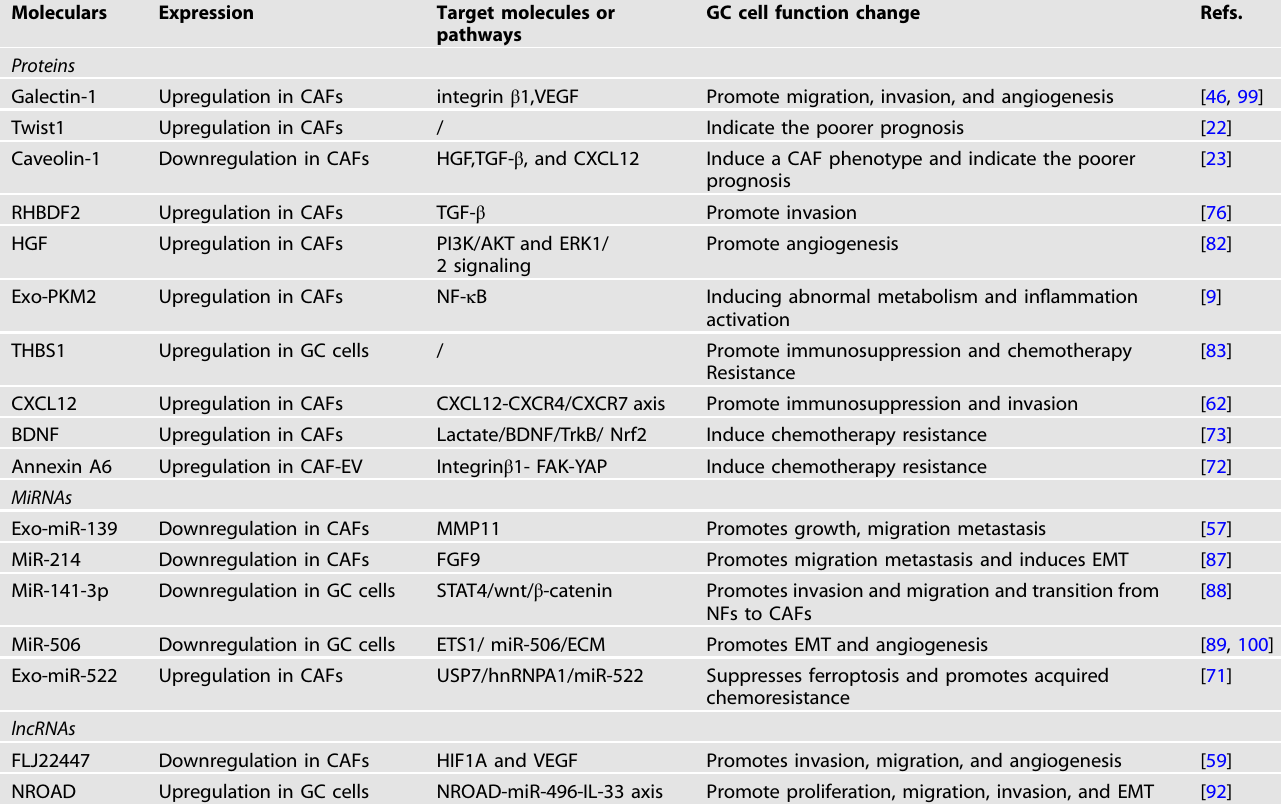
Table 2. Proteins, miRNAs, and lncRNAs in the effect of CAFs on GC cells. Moleculars